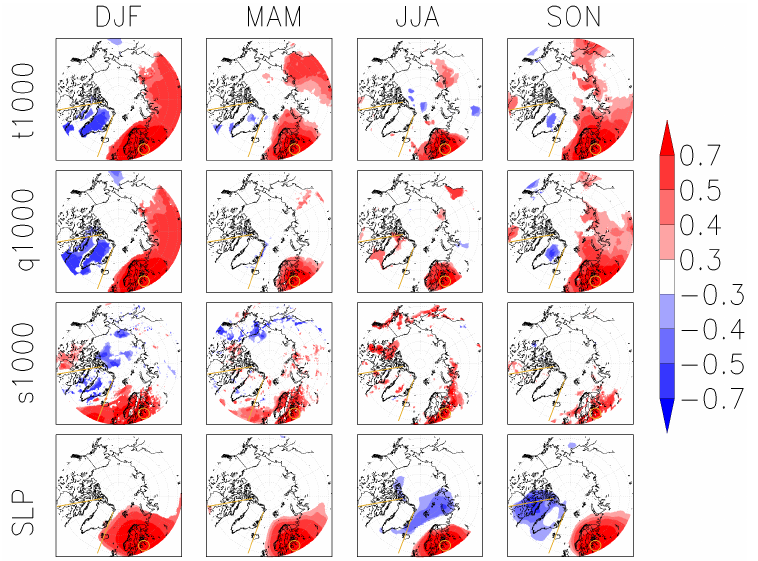
Figure 2. Correlation maps between seasonal mean 1000hPa temperature (t1000), specific humidity (q1000), wind speed (s1000), and SLP measured at the TP (the yellow circle) and in the whole Arctic region. Columns represent seasons; all presented correlations are significant